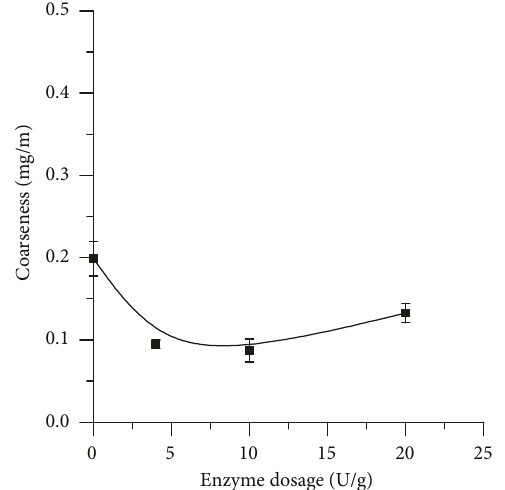
Figure 9: Effect of xylanase treatment on the fine element contents of the